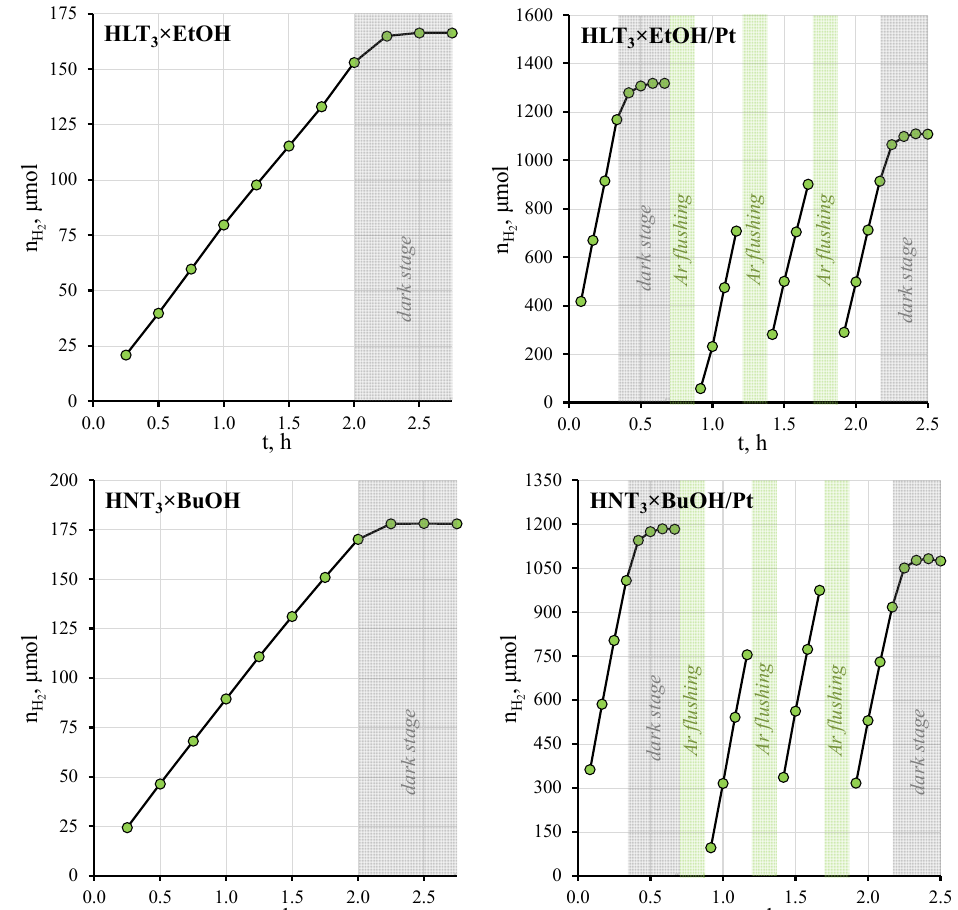
Figure 6. Kinetic curves of photocatalytic hydrogen generation over some bare and platinized inorganic-organic derivatives. Table 4. Data on photocatalytic activity of the protonated titanates and their inorganic-organic derivatives. Sample